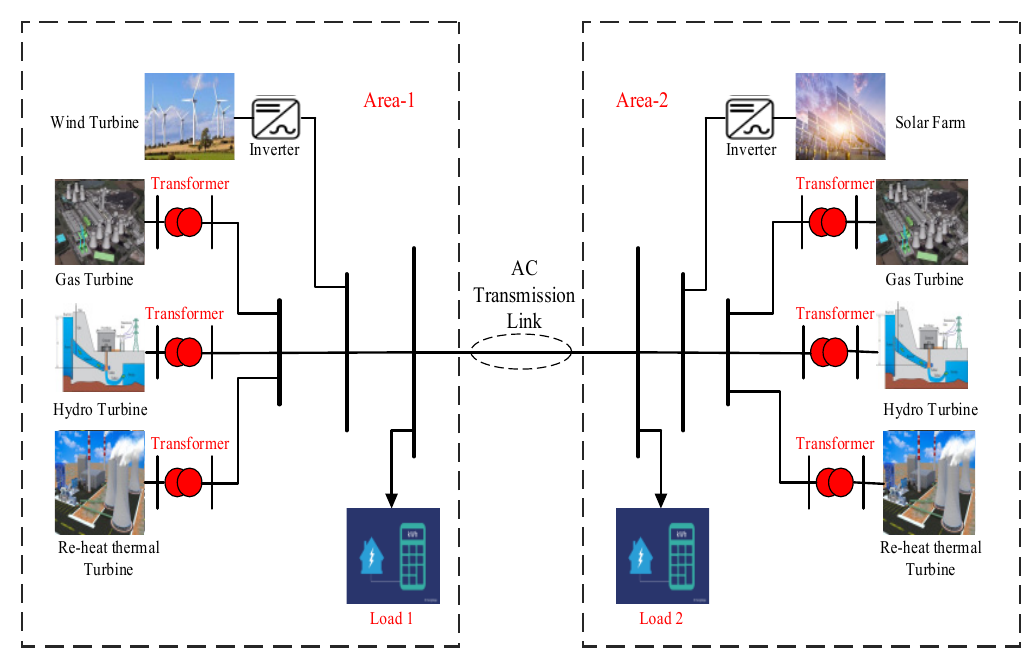
Figure 1. The structure of the studied two-area interconnected power grid.